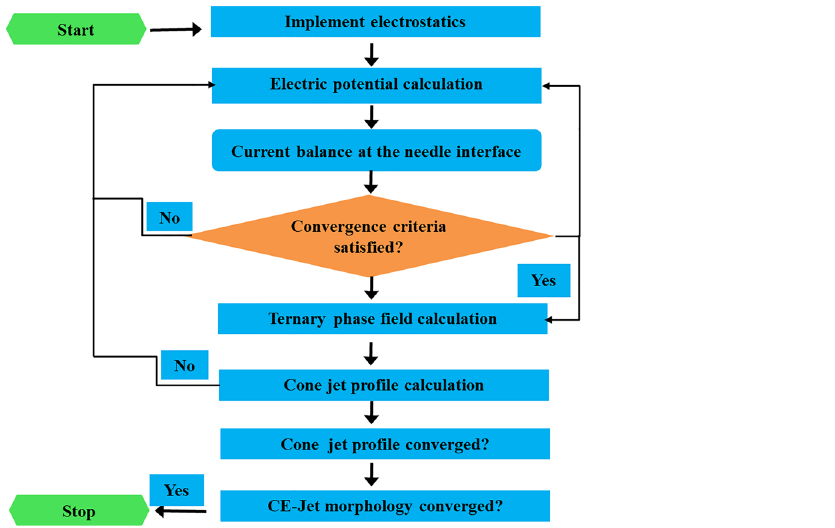
Figure 3. Flow diagram of the phase field